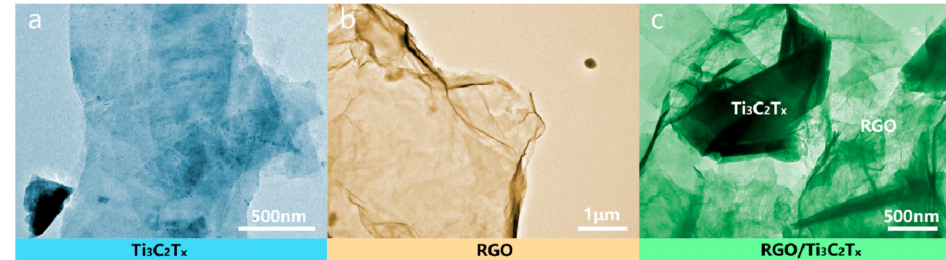
Figure 3. TEM image of Ti 3 C 2 T x ( a ), RGO ( b ), and RGO/Ti 3 C 2 T x ( c